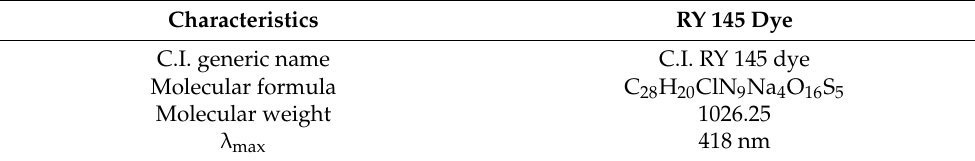
Table 1. Characteristics of RY 145 Dye145 [29,30].